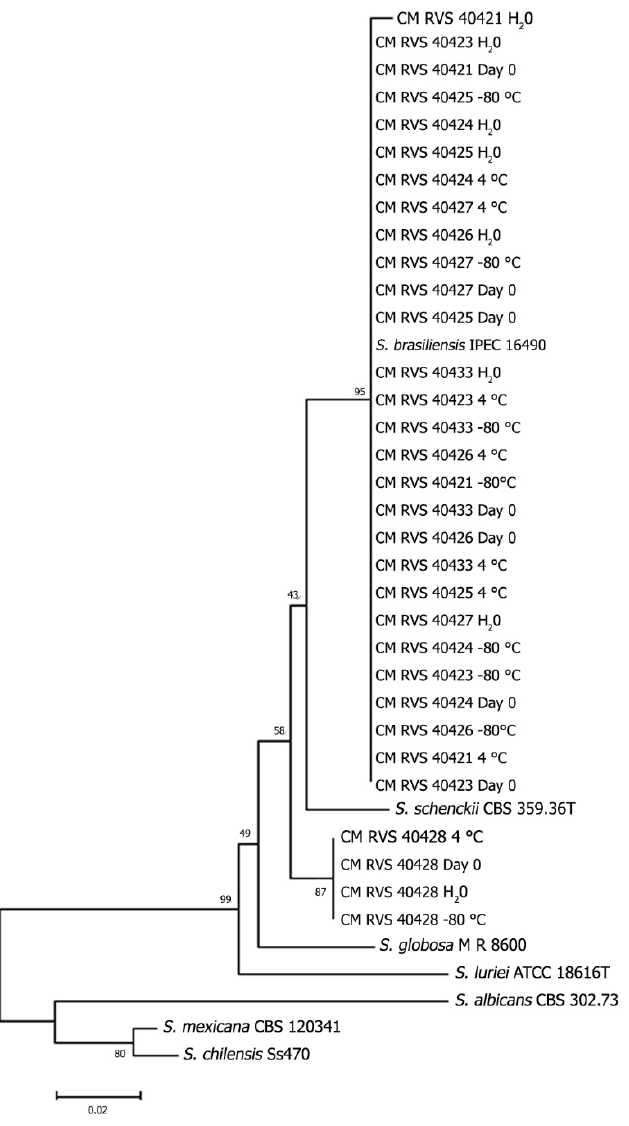
Figure 3. Genotypic stability. Evolutionary relationships of 36 taxa. The evolutionary history was inferred using the Maximum Parsimony (MP) method. Phylogenetic analyses were conducted in MEGA4. The phylogenic tree of partial β -tubulin gene performed for the eight isolates at day zero and after 24 months of preservation. H 2 O = preservation in distilled water; 4C = preservation at 4 ◦ C; − 80 = cryopreservation at − 80 ◦